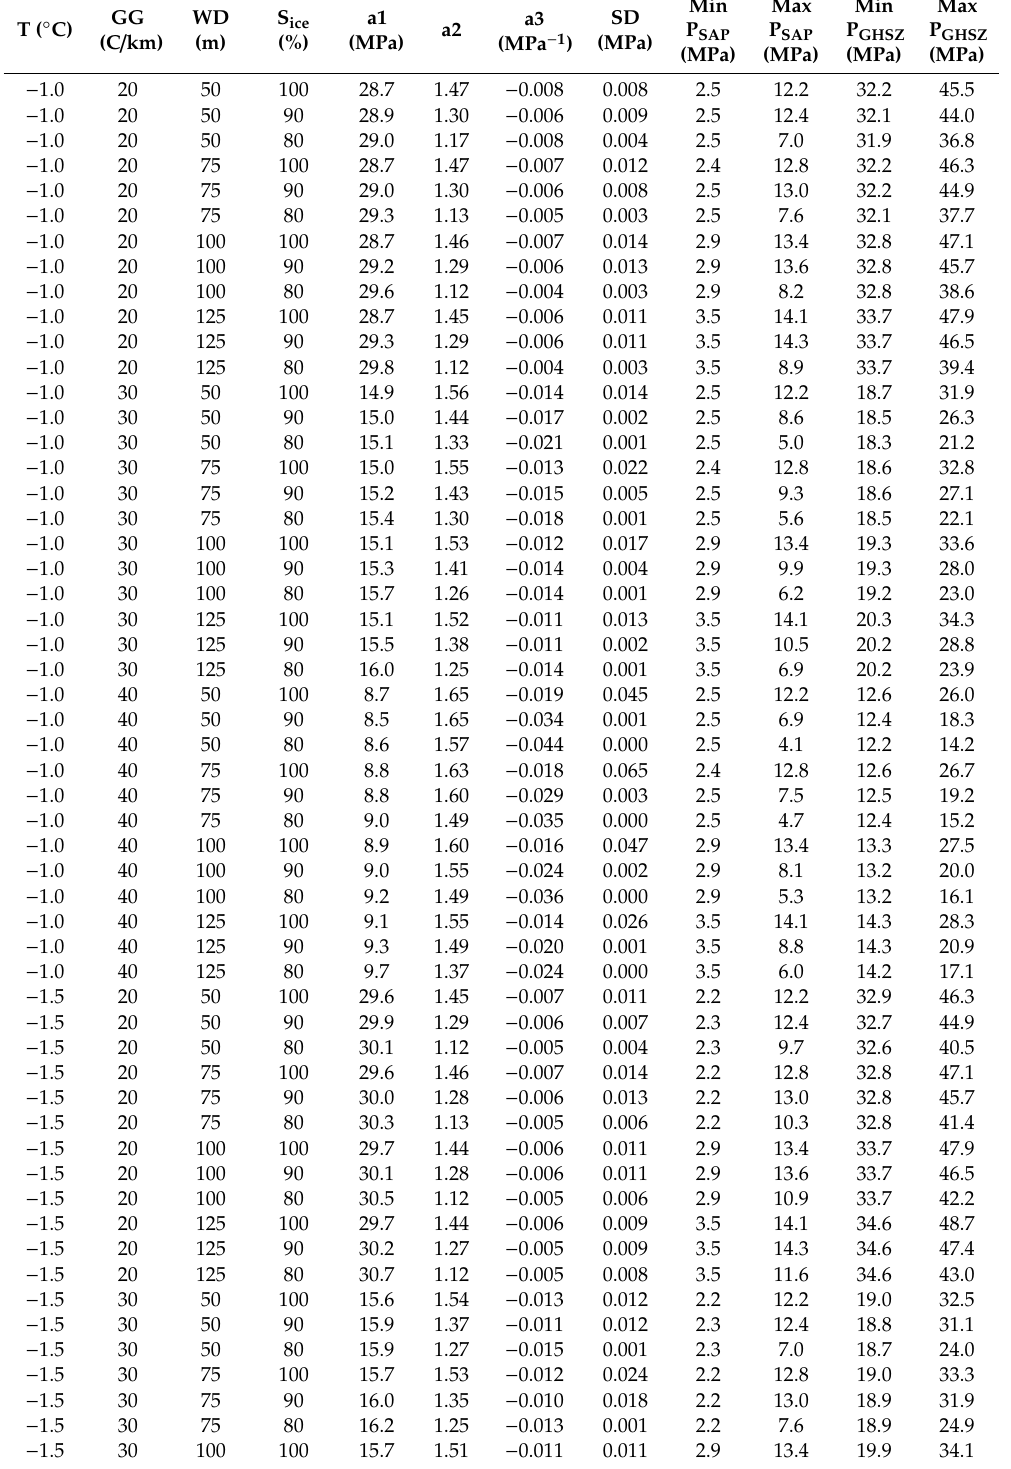
Table 1. Fitting parameters a1, a2, and a3 for modeled bottom water temperatures (T), geothermal gradient (GG), and water depths (WD) for the freshwater case. The standard deviation (SD) is also reported, as well as the range of pressure in which the hydrate stability is satisfied, indicated as Min / Max P SAP and Min / Max P GHSZ